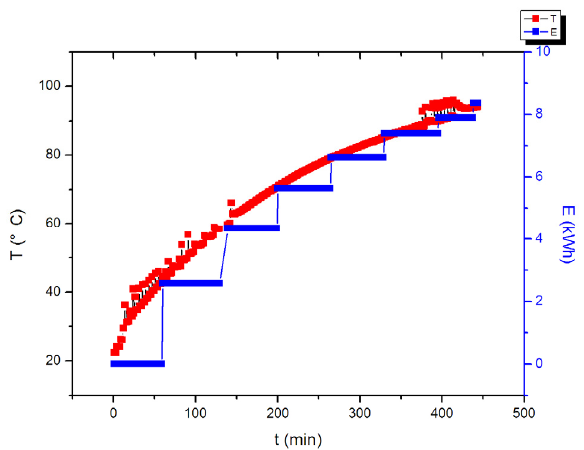
Figure 10. The temperature and heat curve of PT thermal utilization (The temperature curve refers to the water temperature of the collector; the heat meter collect the data once an hour in the experimental test, so there were straight lines when the heat meter had not collected data).